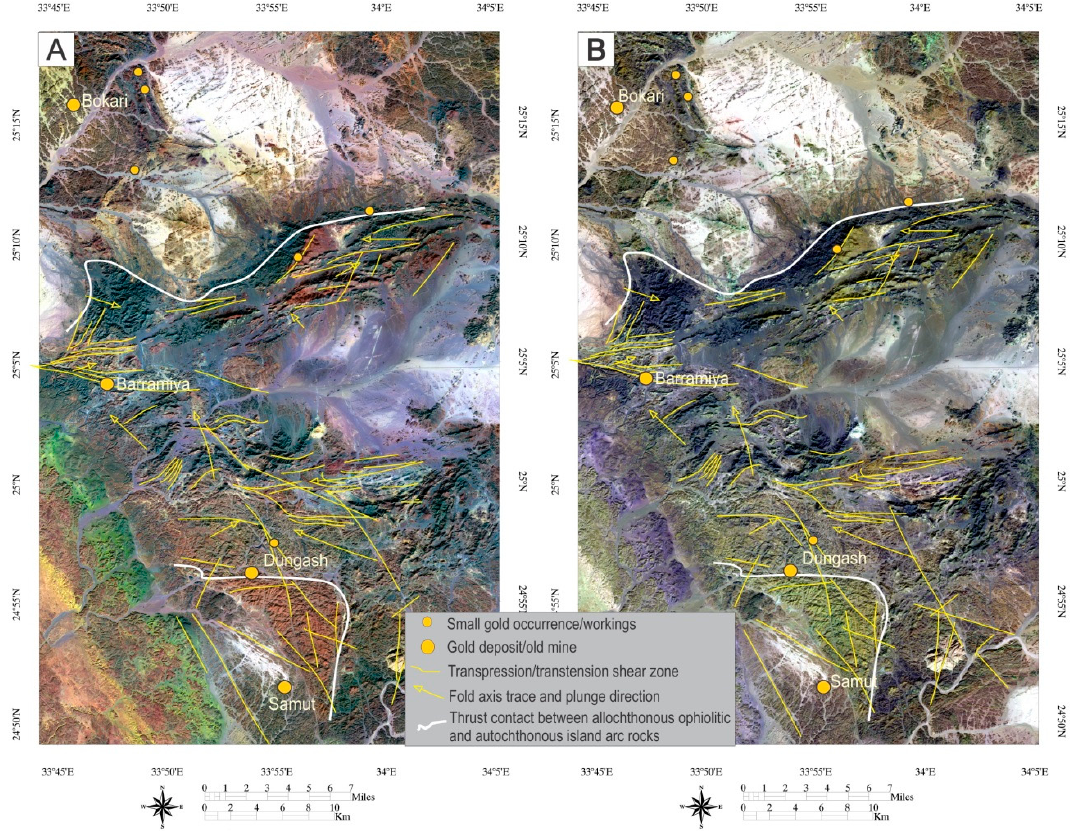
Figure 7. False-color composite, Sentinel-2 band combination images for the study area: ( A ) (R: Band 11, G: Band 8, B: Band 2), and ( B ) (R: Band 11, G: Band 12, B: Band 7) used to map Fe 2 O 3 / MgO and Al 2 O 3 -rich rocks, respectively. These images helped in differentiating the mafic and ultramafic ophiolitic from felsic rocks.